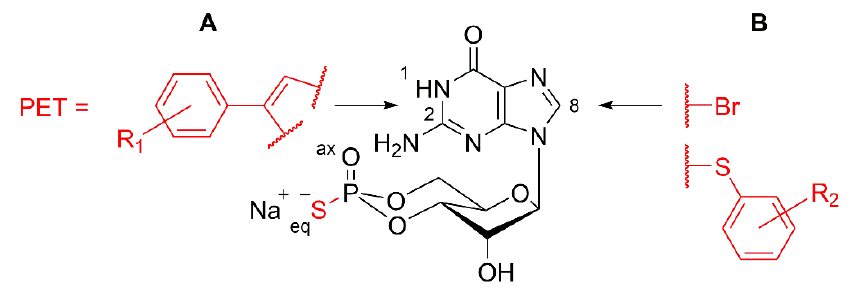
Figure 3. Schematic structure of Rp-cGMPS analogues. Arrows illustrate typical structural positions in Rp-cGMPS used for the introduction of substituents to generate Rp-cGMPS analogues with improved inhibitory potency for cGMP-dependent protein kinase I or II. ( A ) Position 1, N 2 : Addition of β -phenyl-1,N 2 -etheno-modifications (PET) with varying additional substituents (R 1 ) to Rp-cGMPS [65,66]. ( B ) Position 8: Addition of halogens (e.g., bromine (Br)) or sulfur-connected aromatic ring systems with varying additional substituents (R 2 ) [65,67].